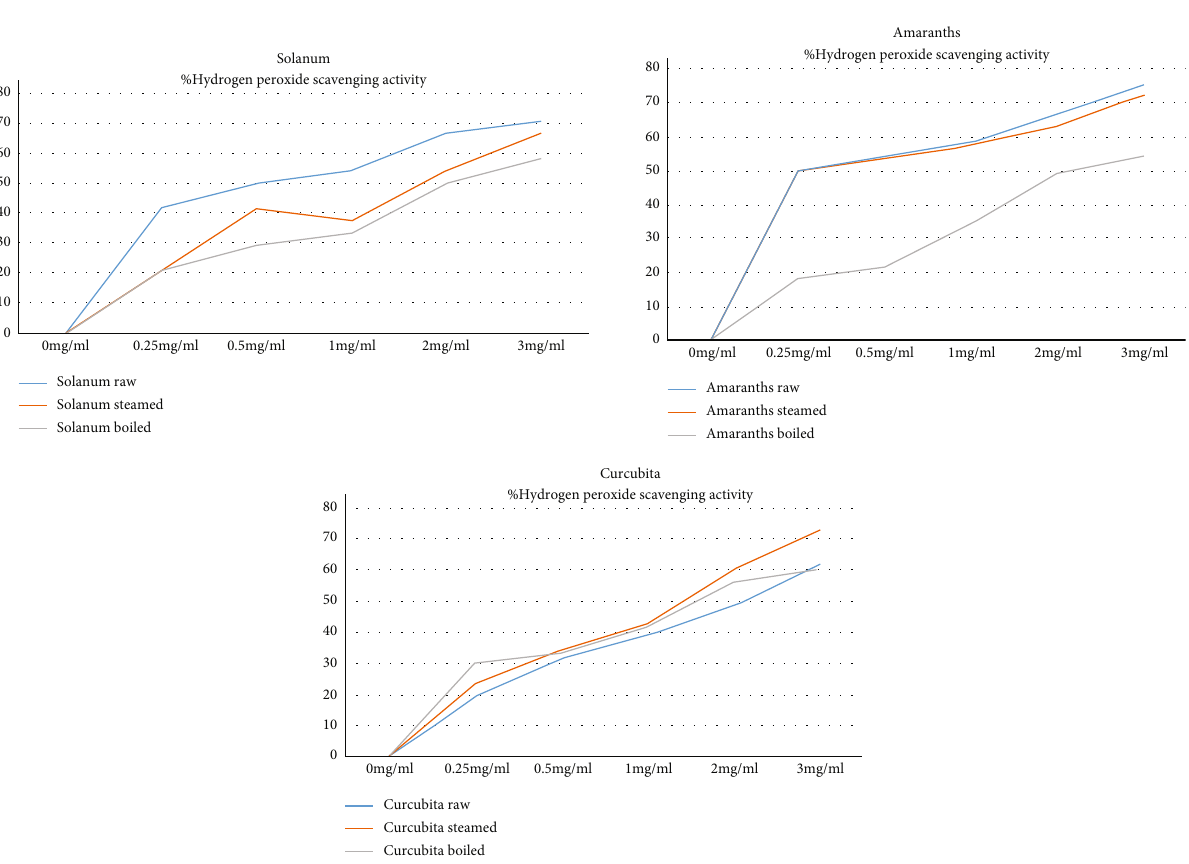
Figure 1: Reducing power of the raw and cooked leafy vegetables.